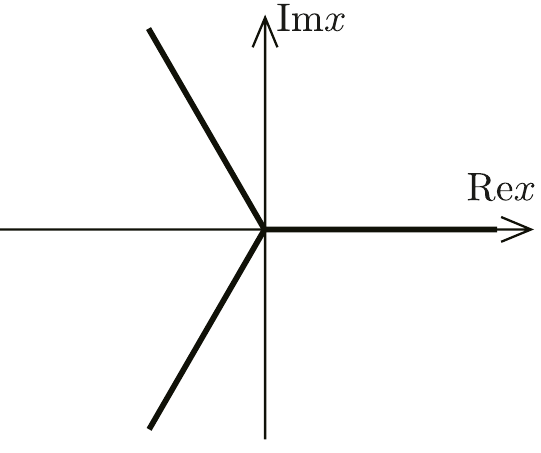
Figure 2 . The Stokes lines for Q = x